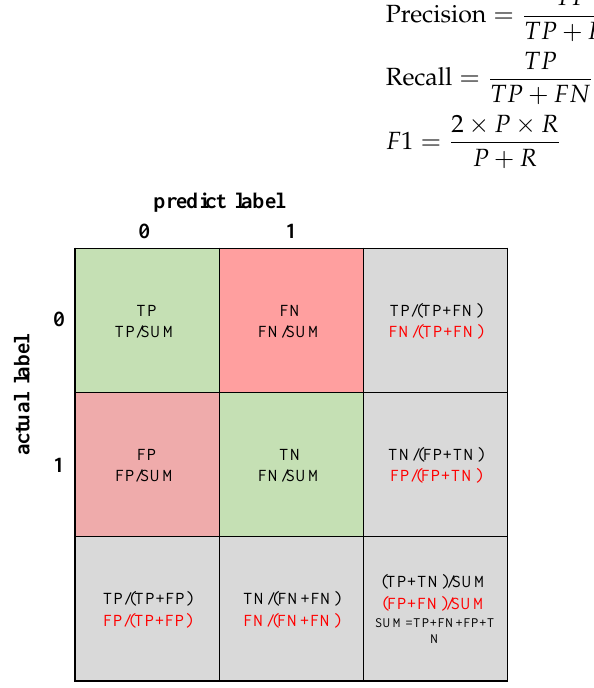
Figure 5. Schematic of the confusion